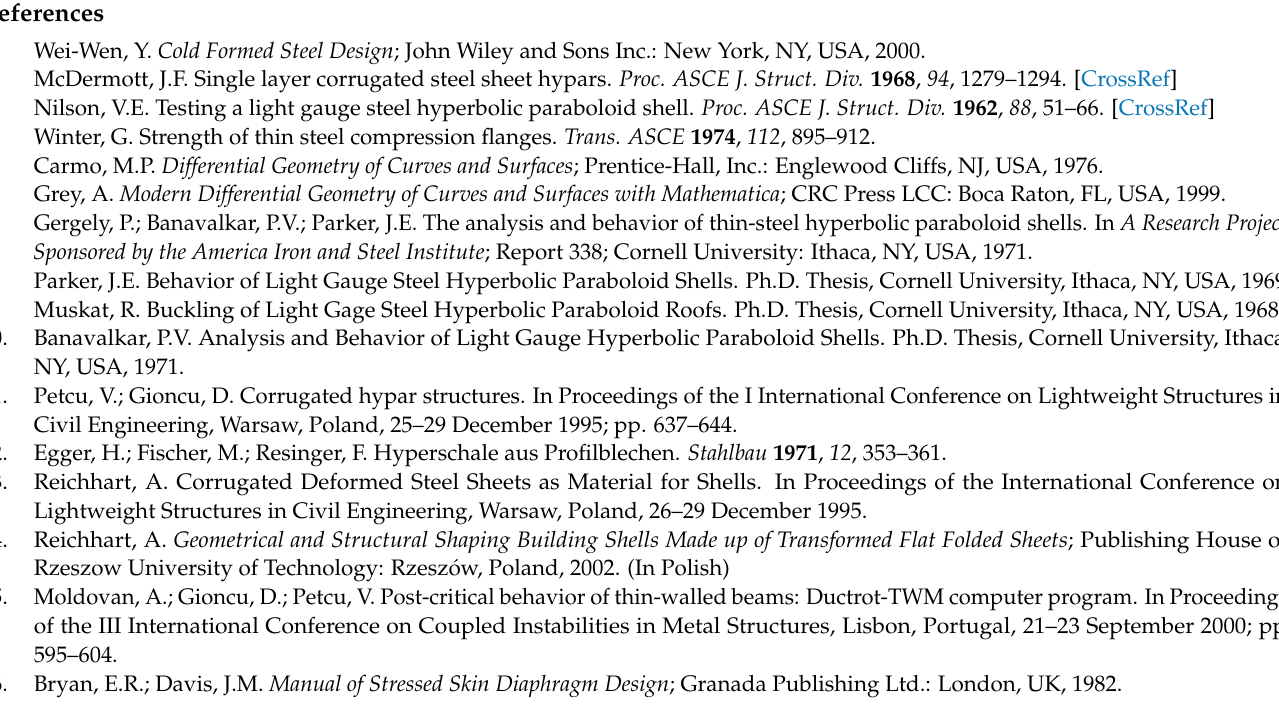
Figure A6. A linear relation between the τ xy shear stresses and γ xy corresponding strains for elements located at the crosswise ends of a shell